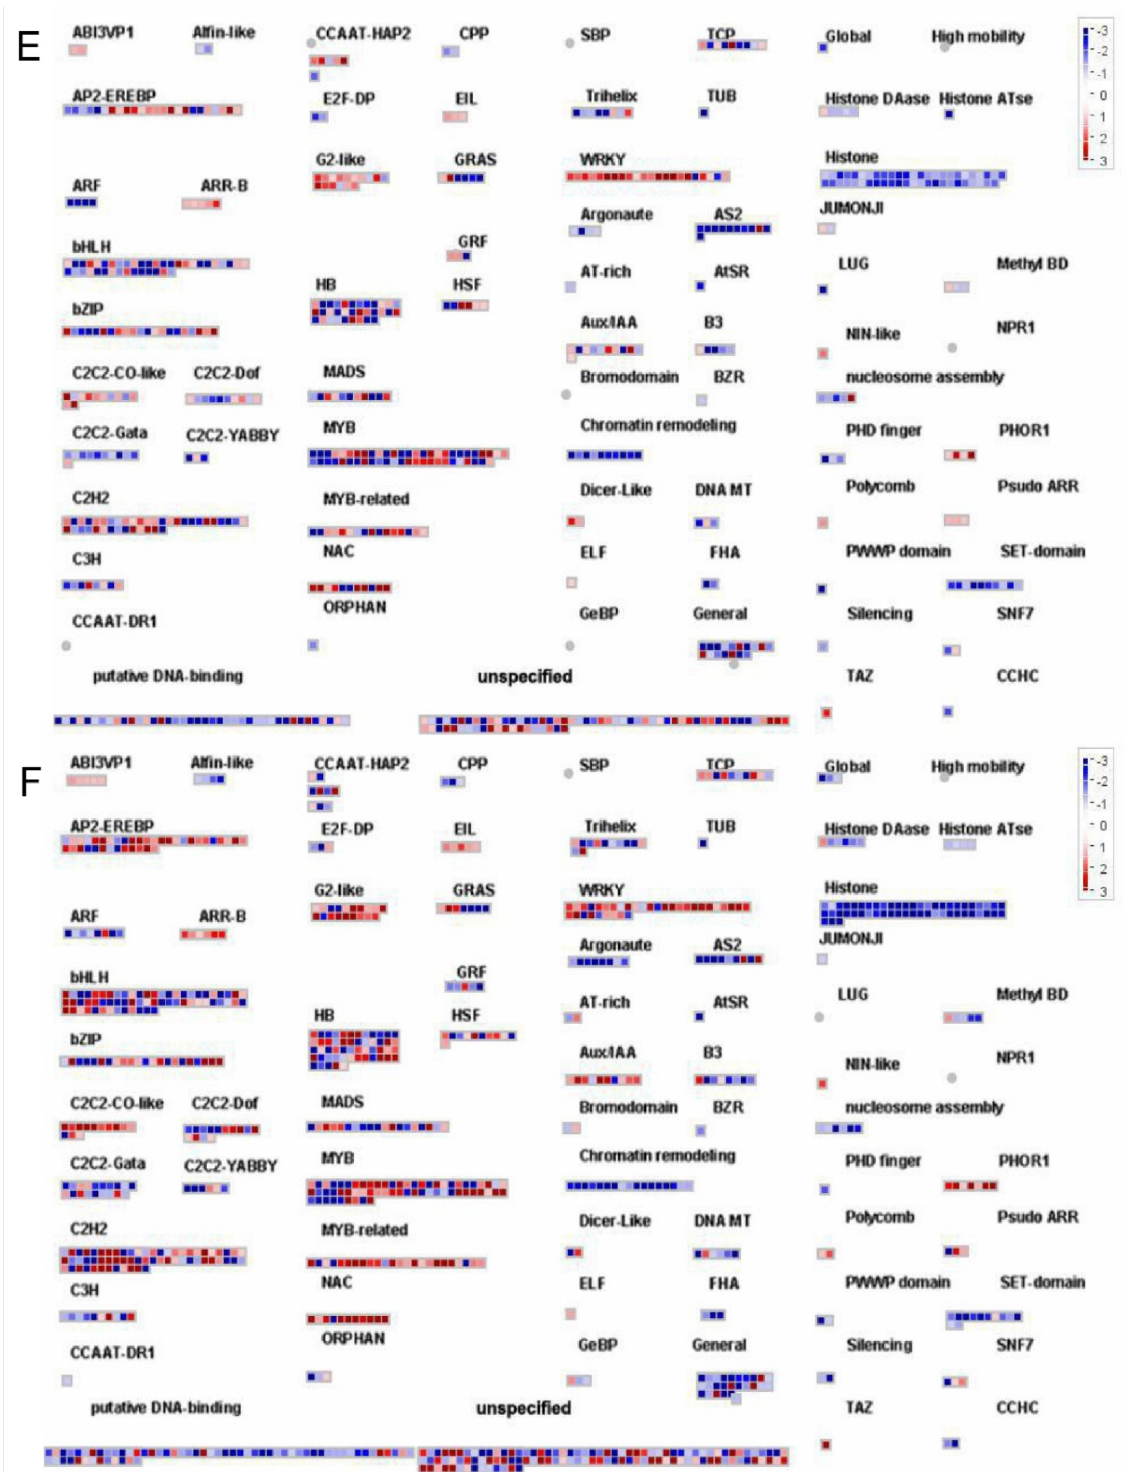
Figure 7. The clustering pattern of DEGs generated with the MapMan tool. ( A ) Overview of DEG regulation in MM1. vs-MM_2. ( B ) Overview of DEG regulation in 20965_1-vs-20965_2. ( C ) Cellular response of DEGs in MM_1-vs-MM_2. ( D ) Cellular response of DEGs in 20965_1-vs-20965_2. ( E ) Transcription of DEGs in MM_1-vs-MM_2. ( F ) Transcription of DEGs in 20965_1-vs-20965_2. Each square represents a separate gene. Red represents upregulation and blue represents downregulation. The color brightness represents the degree of difference (see